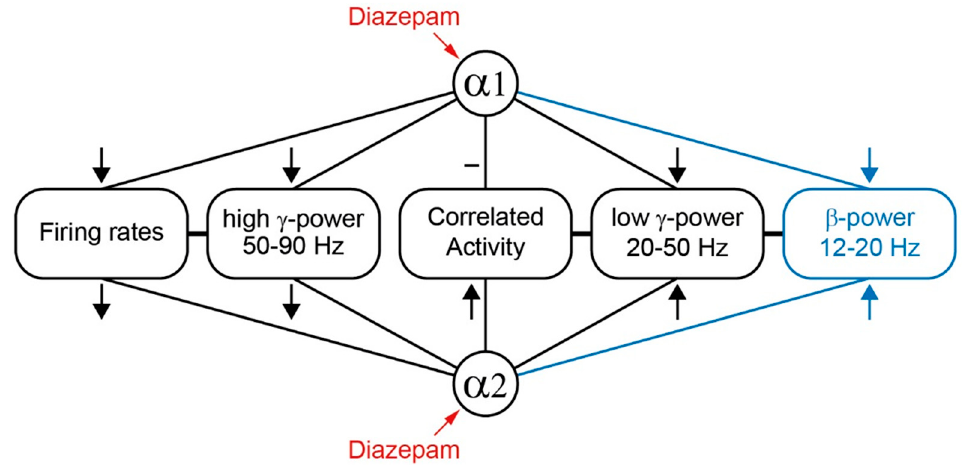
Figure 6. E ff ects of diazepam on electrocortical activity mediated by α 1- and α 2-GABA A receptors. Diazepam’s actions on β -power (blue) were evaluated in studies on single knockin mice [13,21]. From these and our study it is concluded that positive modulation of α 1-GABA A receptors reduces β -, low γ -, high γ -power and spontaneous action potential firing of cortical neurons as indicated by downwardly directed arrows, leaving intracortical correlated activity unchanged. Positive modulation of α 2-GABA A receptors reduces firing rates and high- γ power, supporting the idea of a close relation between these signals, as indicated by the horizontal lines between boxes. Furthermore, modulation of α 2-GABA A receptors increases β -, low γ -power and correlated activity, supporting the hypothesis that these e ff ects are caused by increased intracortical synchrony (indicated by horizontal lines between boxes). Remarkably, β - and low γ -power are modified via α 1- and α 2-GABA A receptors in opposing ways.